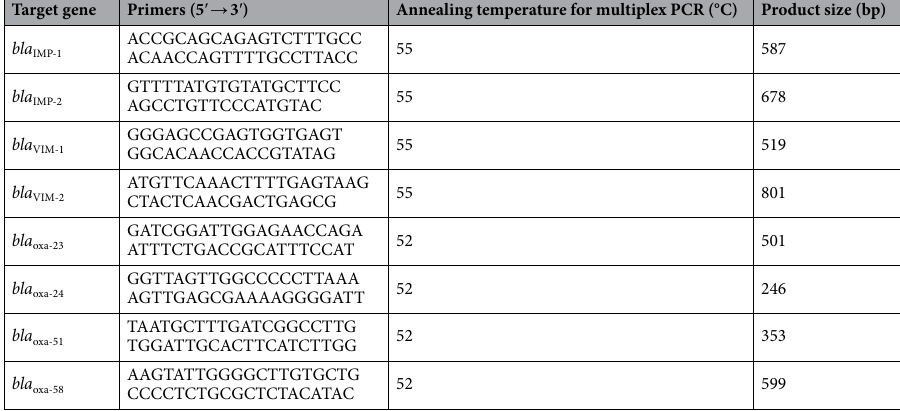
tazobactam (Chong Kun Dang Pharmaceutical Co., Seoul, Korea), ampicillin/sulbactam (Keun-Hwa Pharma- ceutical Co., Seoul, Korea), ceftazidime (Hanmi Co., Seoul, Korea), cefepime (Boryung Co., Seoul, Korea), aztre- onam (Crystal Lifesciences, Cheonju, Korea), minocycline (SK Chemical Co., Seongnam, Korea), fosfomycin (Pharmbio Co., Chungju, Korea), rifampin (Yuhan Co., Seoul, Korea), and ciprofloxacin (Bayer AG, Leverkusen,